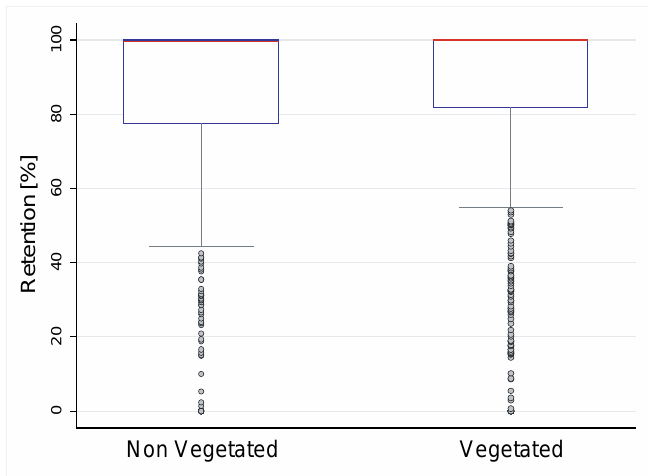
Figure 6. Effect of vegetation on water retention efficiency.